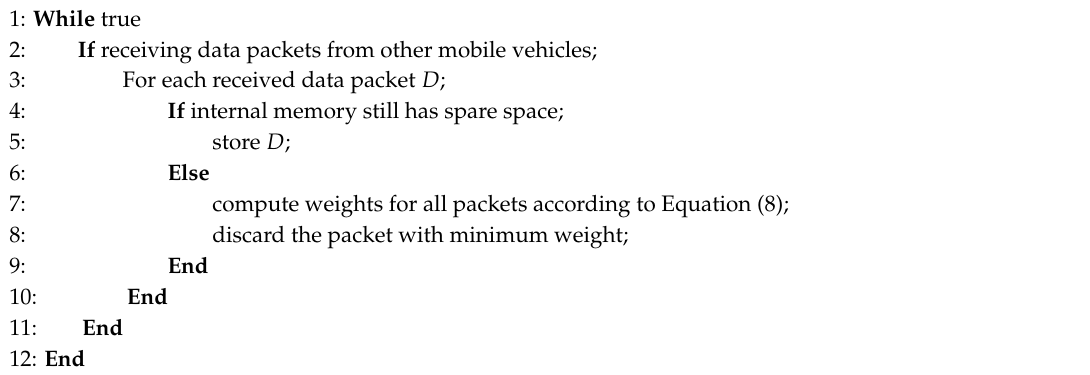
Algorithm 3: Vehicle to Vehicle Transmission (Receiver)